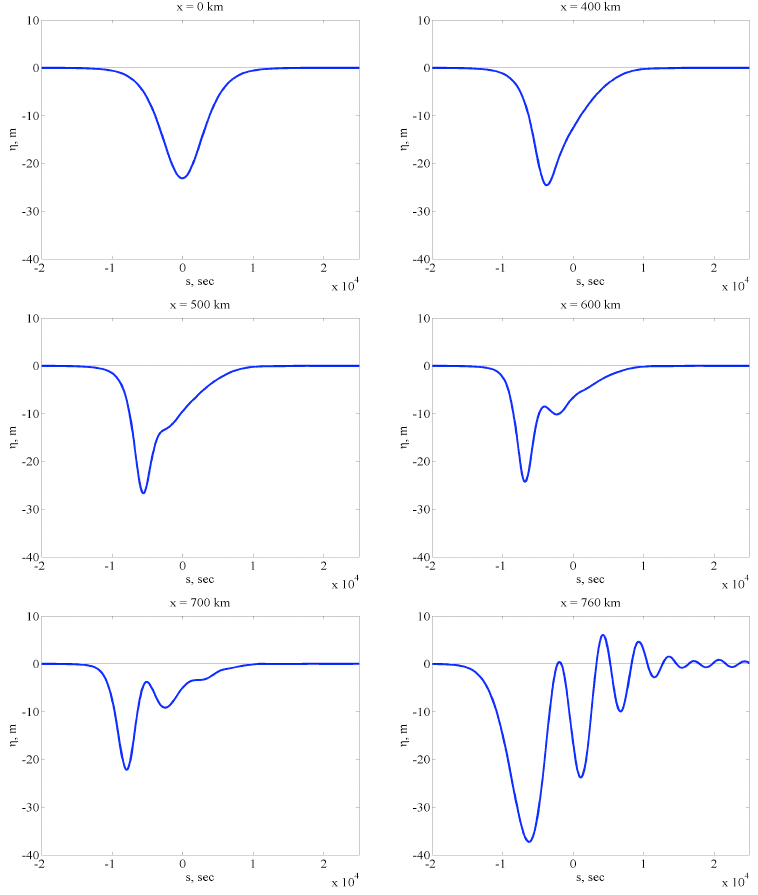
Fig. 16. Transformation of an internal solitary wave along cross-section 2 , initial amplitude 23 m .